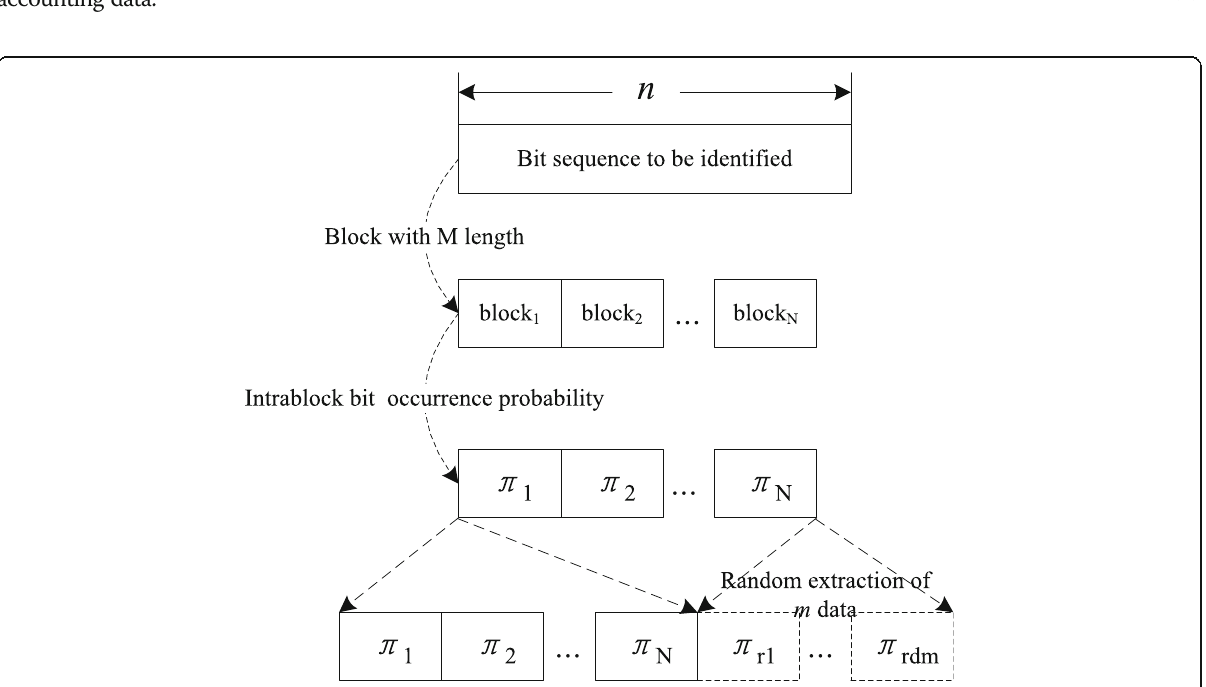
Fig. 2 Cloud computing implementation process of modern accounting